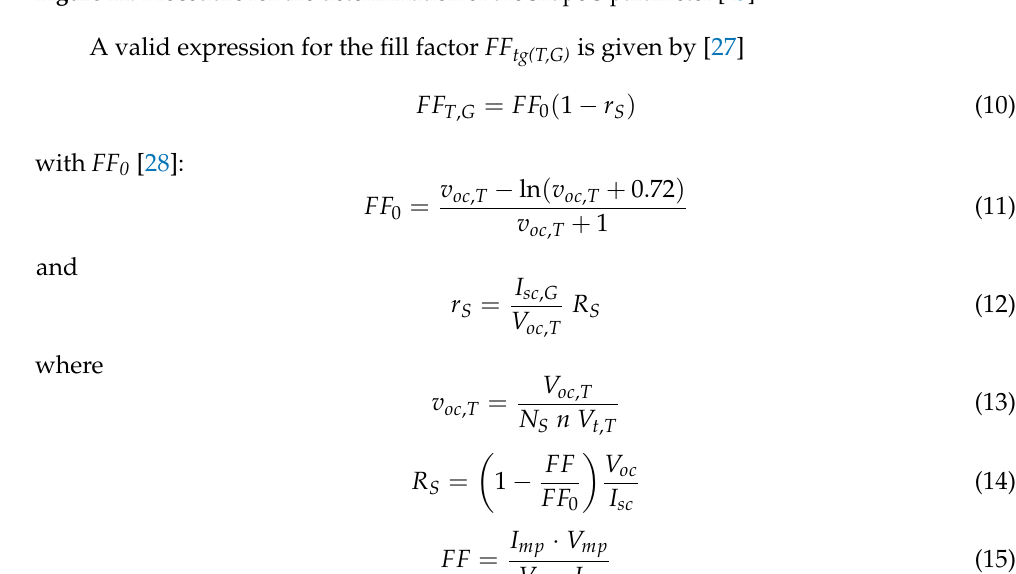
Figure 11. Procedure for the determination of the shape S parameter [25].